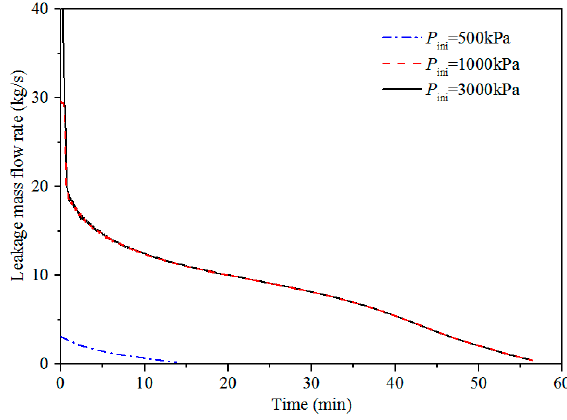
Figure 17. The leakage mass flow rate curves at different initial tank pressures.